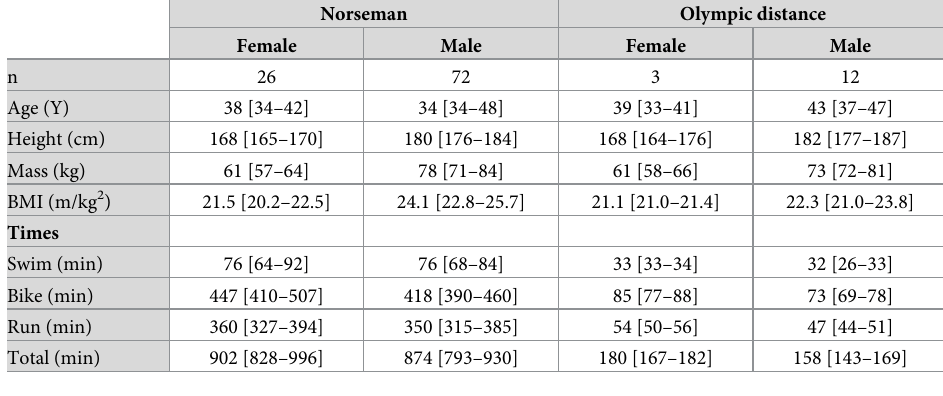
Table 1. Characteristics of included